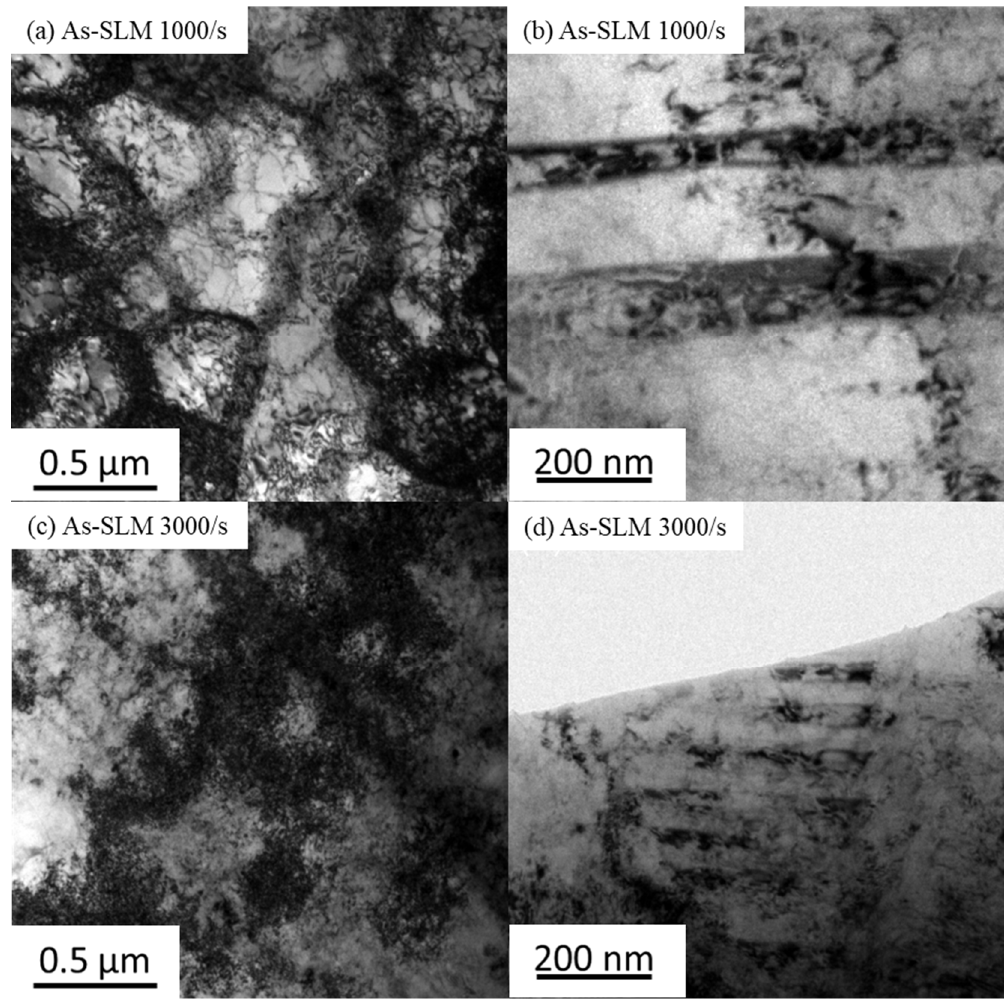
Figure 6. TEM images of the dynamically deformed As-SLM specimens. ( a ) Dislocation cell structure in 1000/s. ( b ) Microbands with spacing of ~150 nm in 1000/s. ( c ) Higher density of dislocations were stopped by cell walls in 3000/s compared to that in 1000/s. ( d ) Microband density increased and microbands had an average spacing of 30 nm.